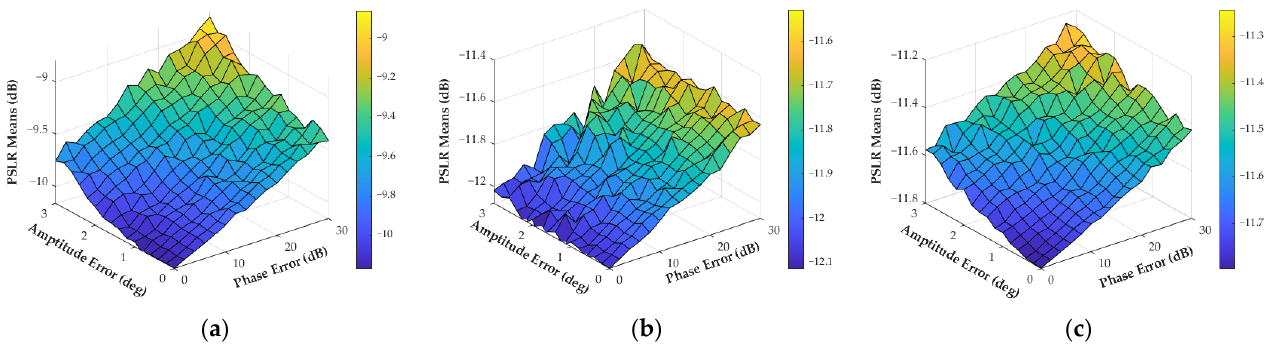
Figure 8. The sidelobe suppression performance with amplitude-phase errors: ( a ) SRS detection type; ( b ) MRS detection type; ( c ) LRS detection type.